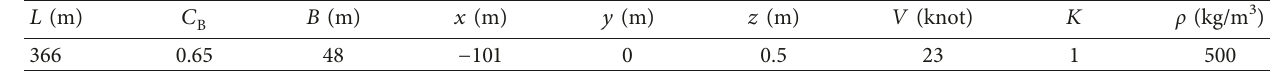
Table 3: Specification of the target ship with the type-B independent tank.